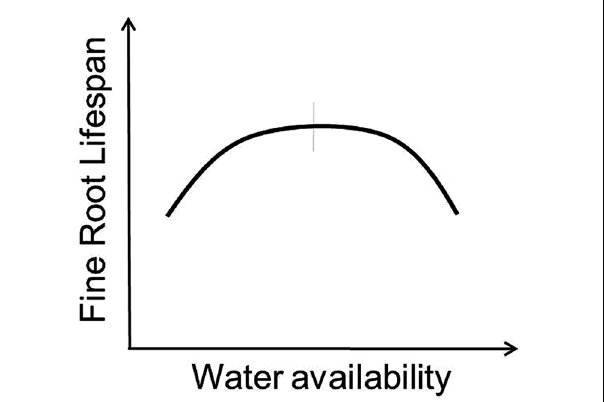
FIGURE 3 | Conceptual model indicates predicted response of fine root lifespan to altered water availability. Vertical gray bar indicates “average” conditions experienced by a given species across its native